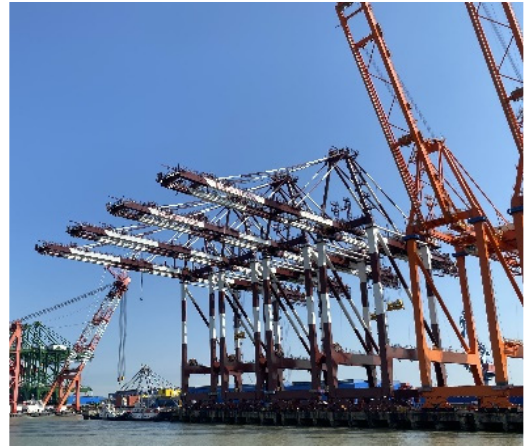
Figure 1. Quay Container Cranes.